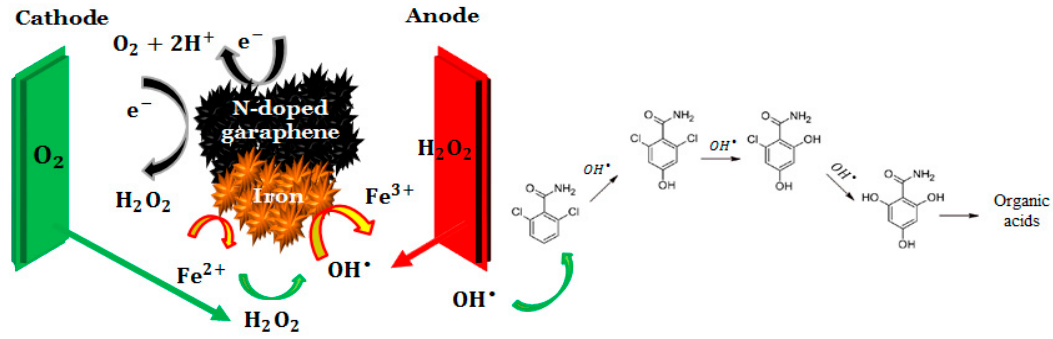
Figure 7. Proposed degradation pathway of model pollutant on synthesized particle electrodes along